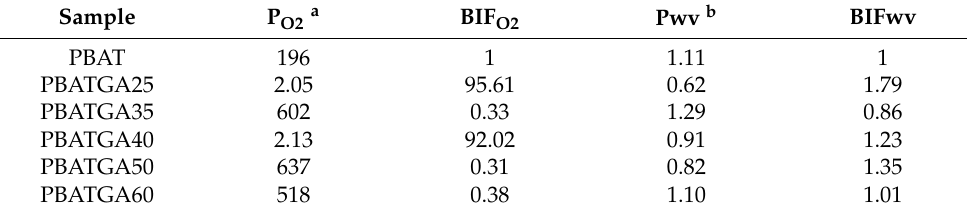
Table 3. Oxygen and water vapor barrier performance of PBATGAs